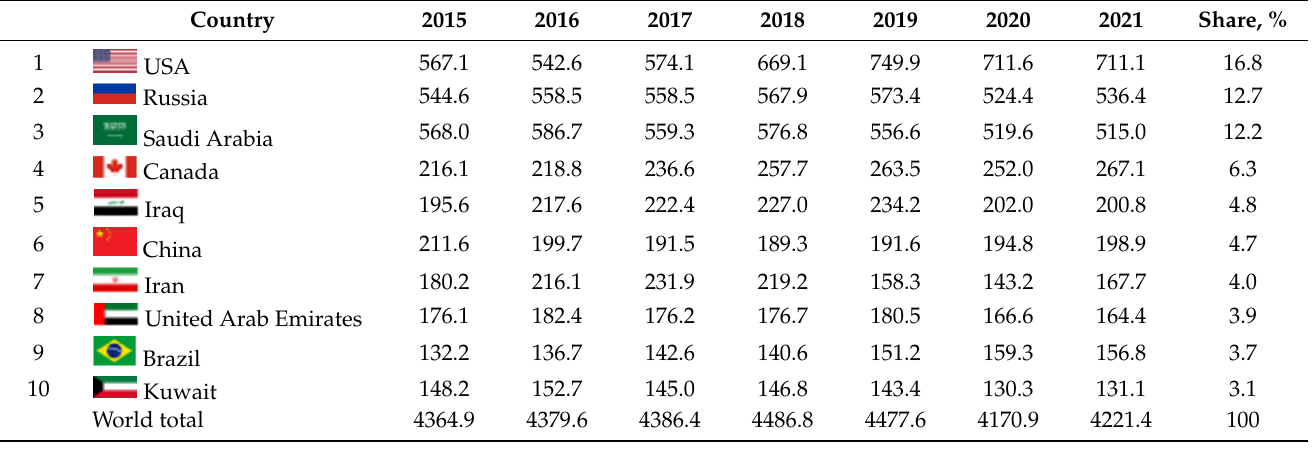
148.2 The Russian Federation ranks 8th in proven oil reserves with reserves of 80 billion. barrels, which is 4% of global reserves, and for the production conditions of the Russian Federation, the use of this volume is likely to be 22.5 years. At the same time, the availa- bility of reserves in the main oil-producing countries is: 86 years in Saudi Arabia, and more than 100 years in Iran and Venezuela. Assessing the oil reserves of the Russian Fed- eration by districts, it should be noted that the state reserves balance takes into account 2525 oil fields, of which about 2/3 of the explored reserves are concentrated in 150 large facilities, and most of the Russian fields are medium and small and their share in many regions reaches 20–50%. Empirical analysis of oil reserves in the context of federal districts revealed their shares in the domestic market [17]: Ural, 36%; Volga, 22.6%; Siberian, 16%; Table 2. Dynamics of oil production by the leading countries of the world and the share in world production for 2015–2021, million tons (Compiled according to the “Statistical Review of World En- ergy 2022”, British PetroleumBp Statistical Review of World Energy/2022 p. 16 [Electronic resource].